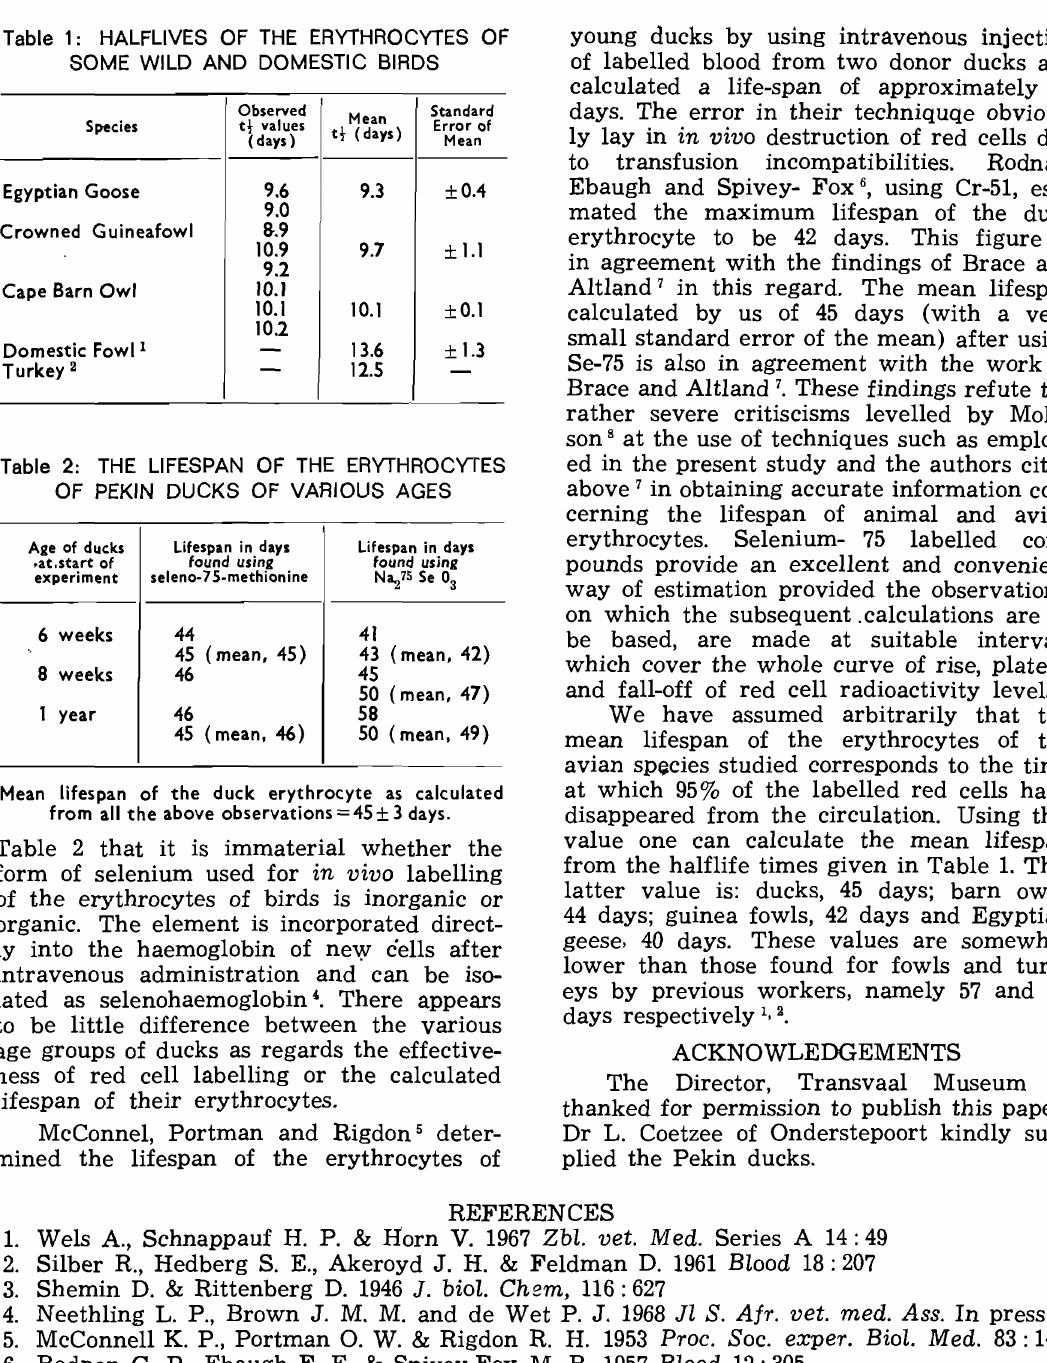
Table 1: HALFLIVES OF THE ERYTHROCYTES OF SOME WILD AND DOMESTIC BIRDS